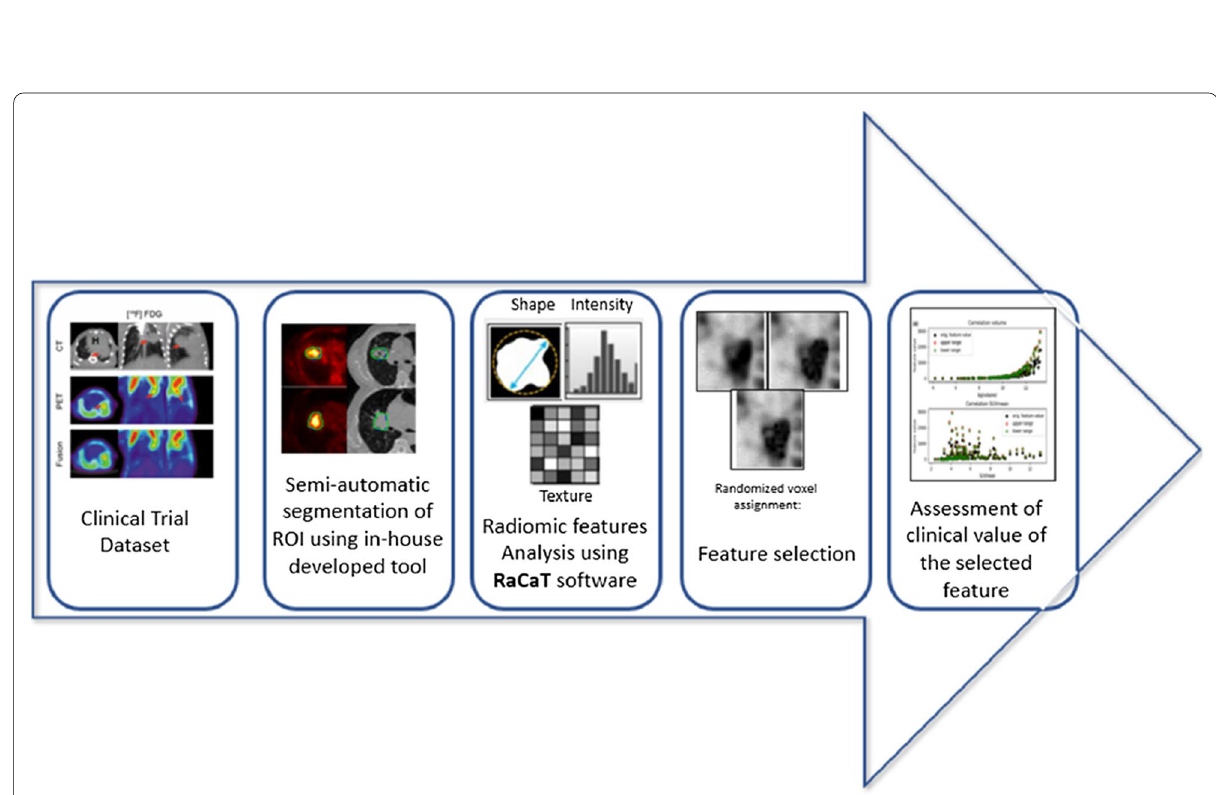
Fig. 7 Workflow of feature selection procedure for reproducible textural feature identification describing relevant texture and independent of conventional PET metrics